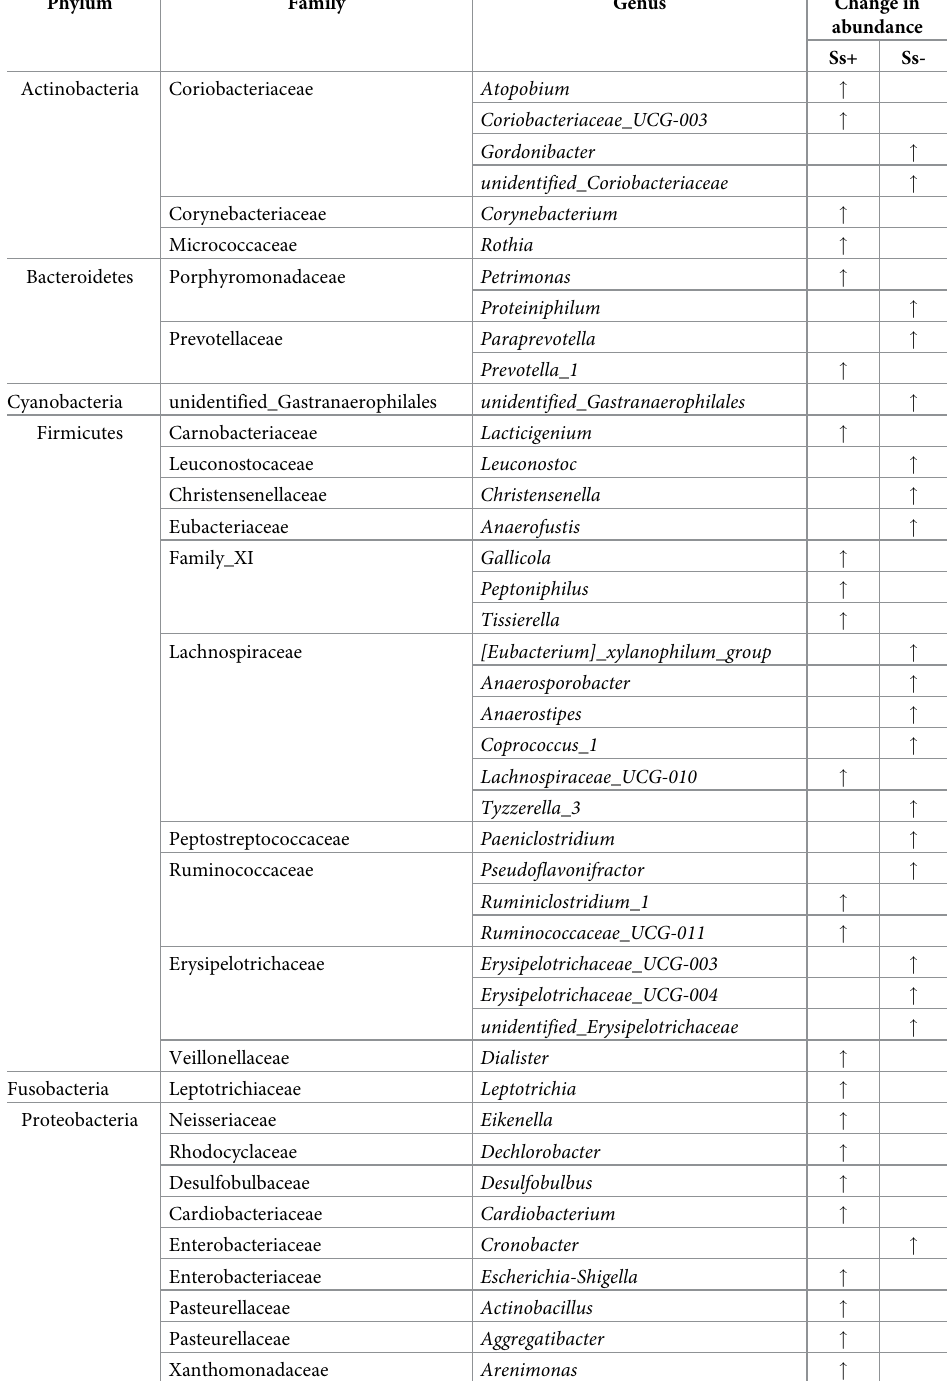
Table 3. Taxa in the gut microbiome differing significantly between CKD patients with and without S . stercoralis